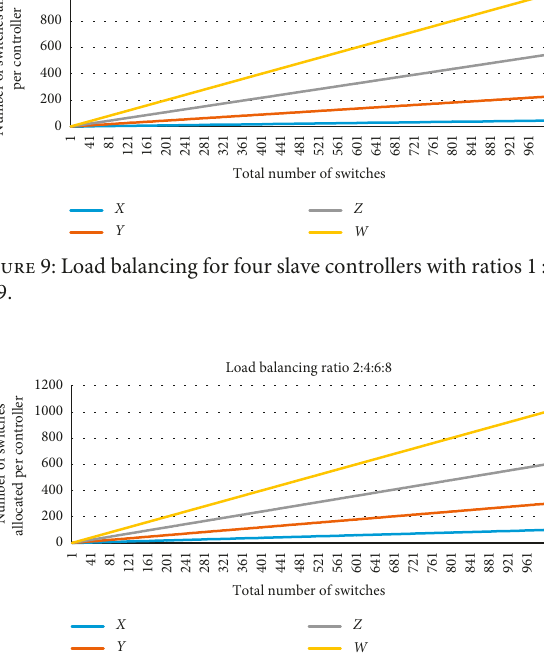
Figure 10: Load balancing for four slave controllers with ratios 2: 4:6